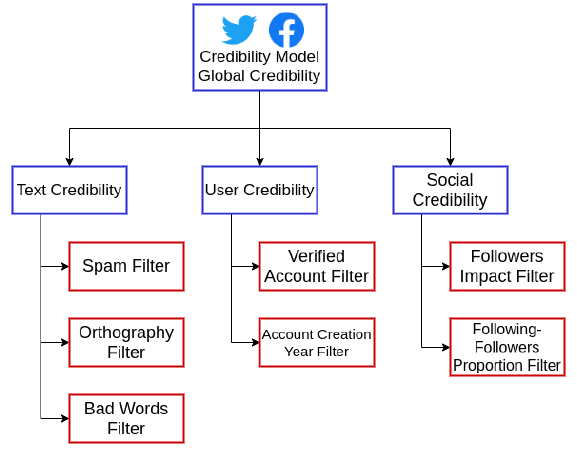
Figure 5. Original credibility model